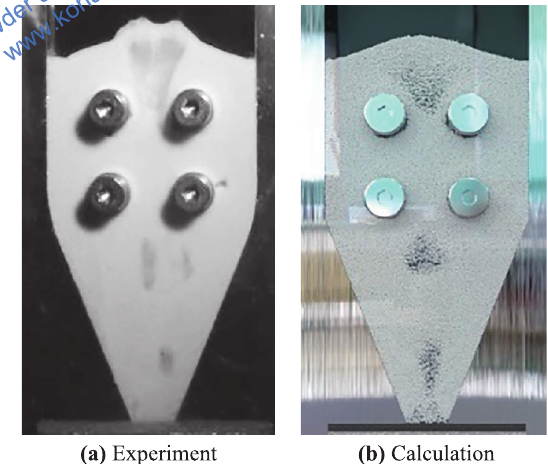
Fig. 7 Validation test result in a fluidized bed (Mori, Wu and Sakai, 2019) Copyright: (2019) Elsevier